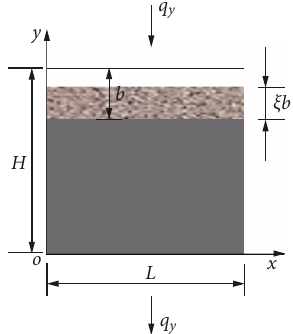
Figure 2: Fractured rock seepage model along the y